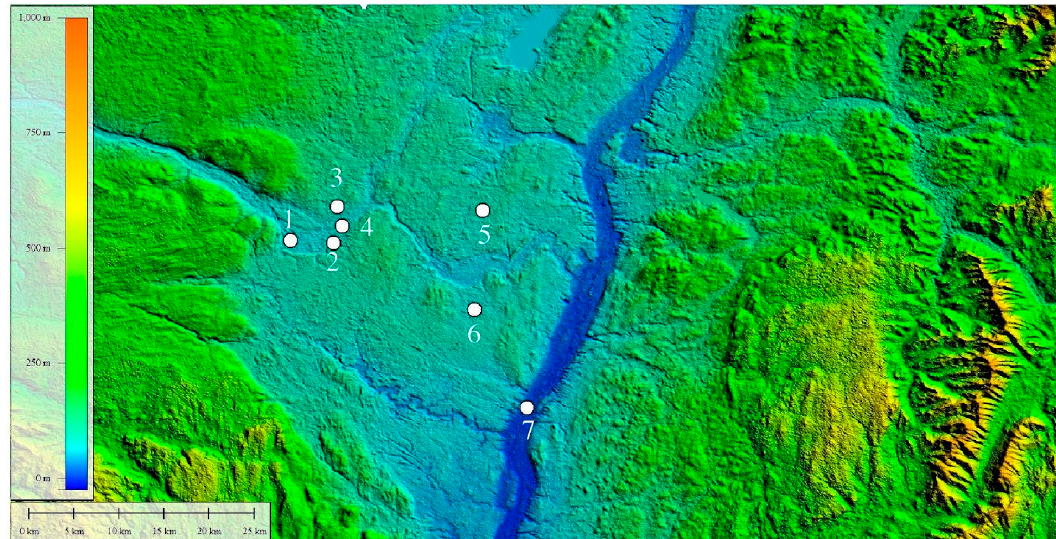
Figure 3. A digital elevation model of the studied area along Freeman’s bridge in Schenectady NY (SRTM; Shuttle Radar Topography Mission data). The vertical scale is significant of vertical elevation in meters without exaggeration, and the horizontal scale shows distance in kilometers. White round markers represent the monitoring stations. The following numbers correspond to the locations of the monitoring stations of the studied area: (1) United Sates Geologic Survey (USGS)well 424859073585501, (2) Schenectady County, (3) Atmospheric air pressure data Station Weather Bureau Army Navy (WBAN) 04741 (4) Water Discharge Station Id 01354500, (5) USGS Well 425048073472501, (6) Albany International Airport Weather Station GHCND:USW00014735 and (7) Tide Data Station ID